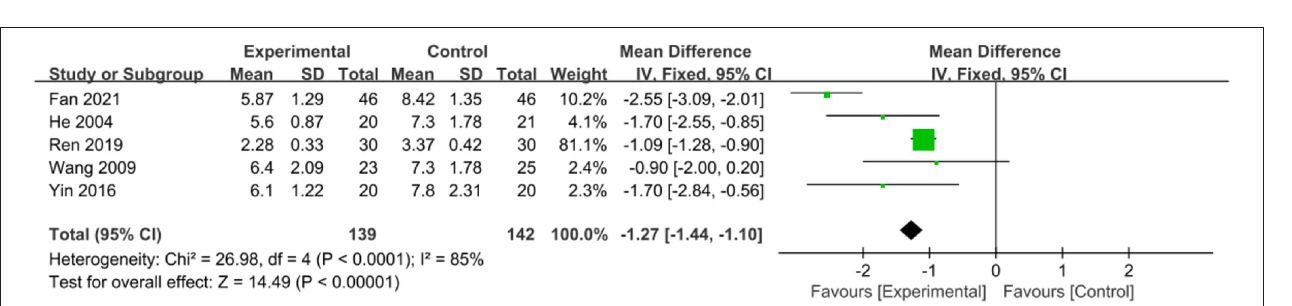
FIGURE 8 | Forest plots of bloating recovery time associated with experimental group (parenteral or enteral nutrition group supplemented with Gln) vs. control group (conventional nutrition group). I 2 tests and P are the criteria for the heterogeneity test, (cid:7) , pooled mean difference; — (cid:4) —, mean difference, and the edges of (cid:7) , 95%